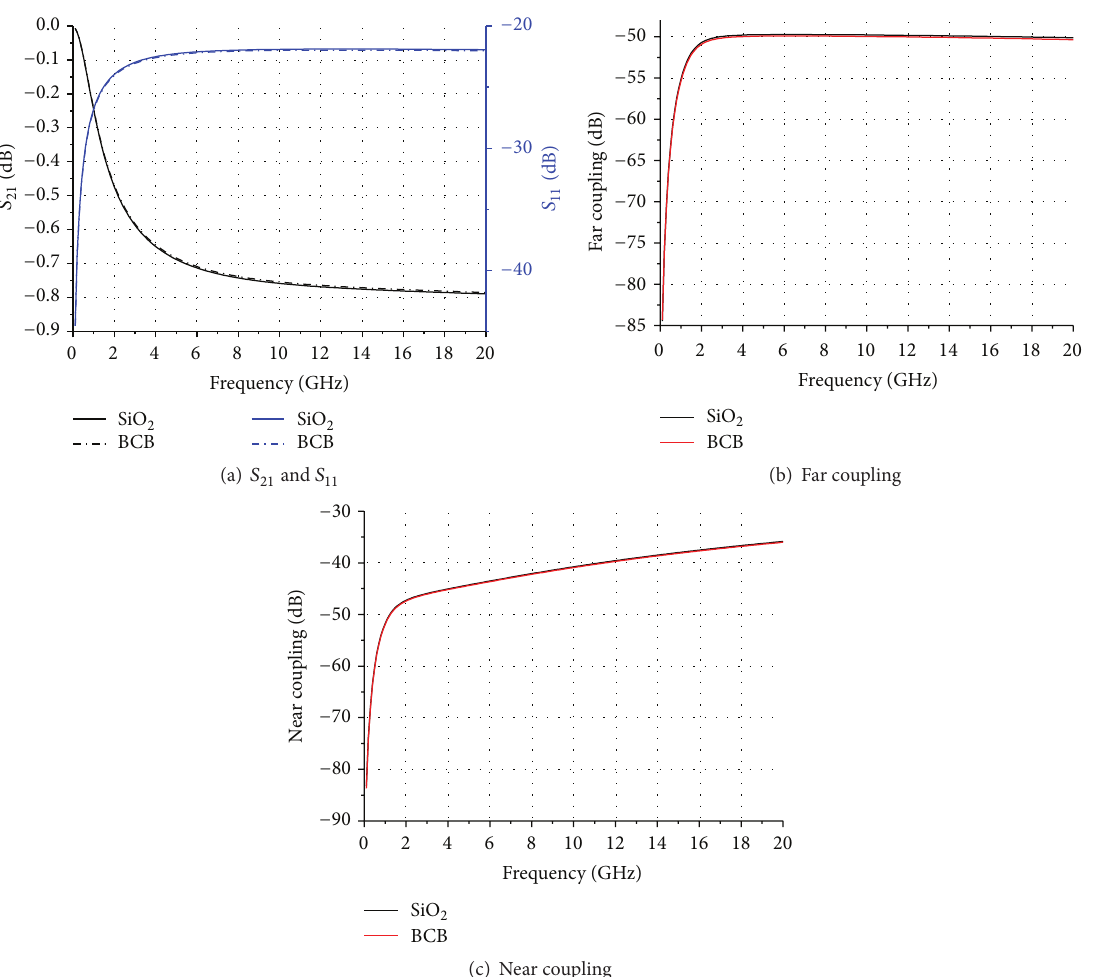
Figure 8: 𝑆 parameters of the TSV model with different underfill